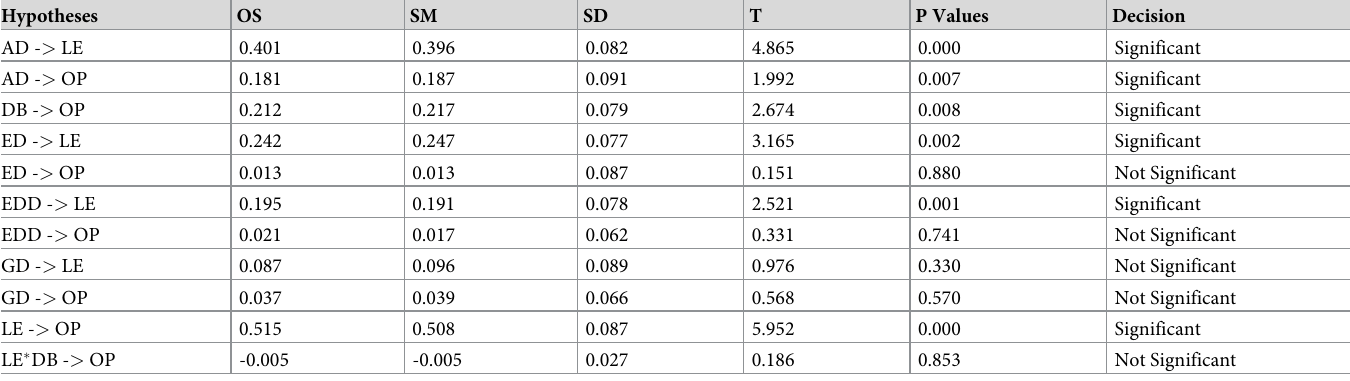
Table 5. Direct and moderating